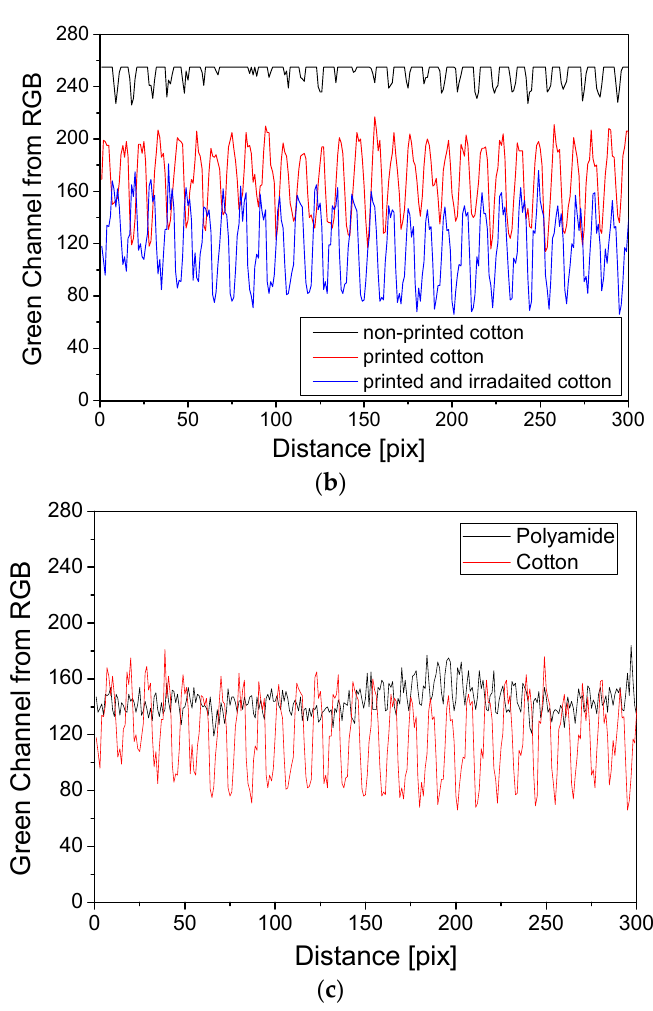
Figure 8. ( a , b ) Analysis of polyamide and cotton fabrics—the green RGB channel profiles (1 pix = 0.1 mm) for (i) non-printed, (ii) printed and non-irradiated and (iii) printed and irradiated with 0.5 J/cm 2 of UVB irradiation polyamide ( a ) and cotton ( b ) fabrics; ( c ): Comparison of polyamide vs. cotton fabrics irradiated with 0.5 J/cm 2 of UVB.